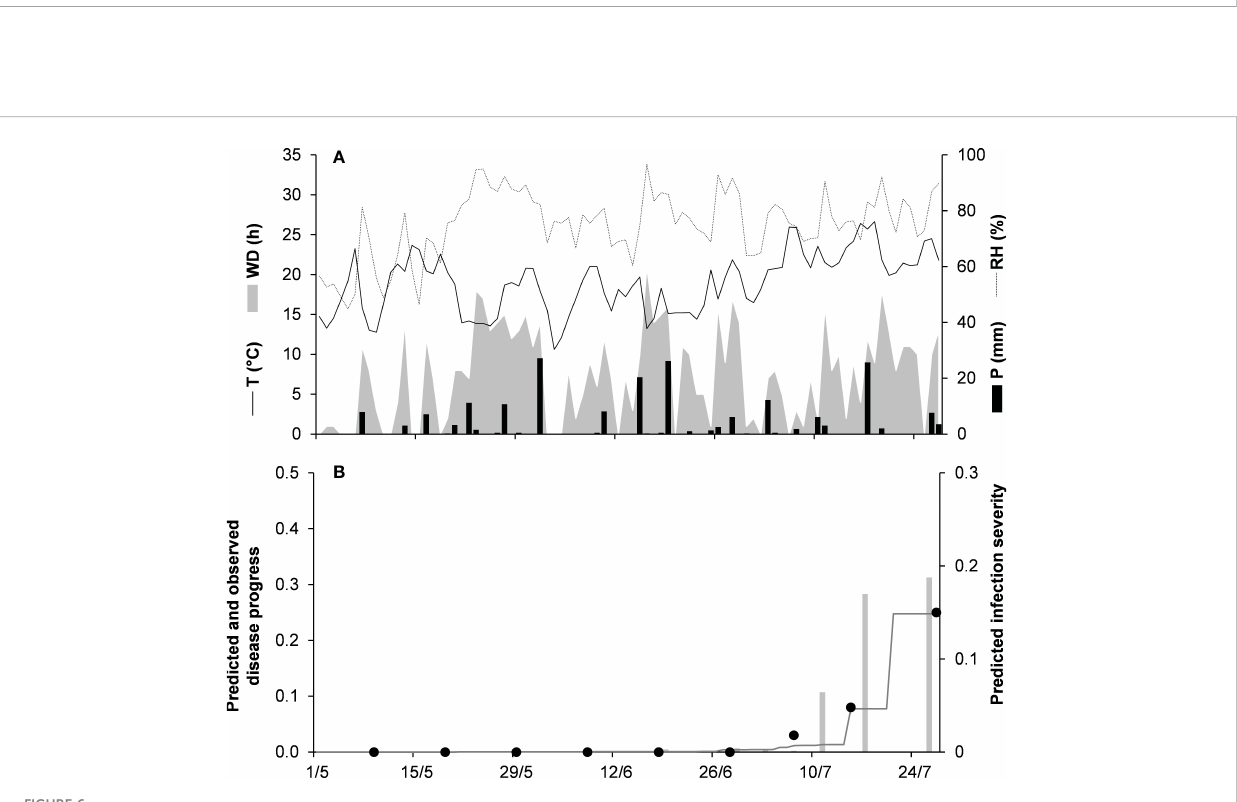
FIGURE 6 Predicted and observed disease progress on bluegrass for the graminicola clade in East Lansing, Michigan, USA, in 1982 (MI-82). (A) Weather variables: air temperature (T, °C, solid line), relative humidity (RH, %, dotted line), rainfall (P, mm, black bars), and wetness duration (WD, in h, gray area). (B) Infection severity predicted by the model (light gray bars), disease severity predicted by the model (dark gray line), and observed disease incidence (full